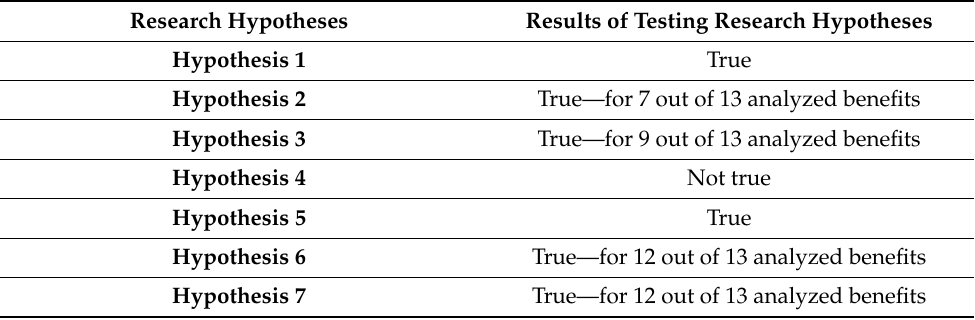
Table 9. Results of testing research